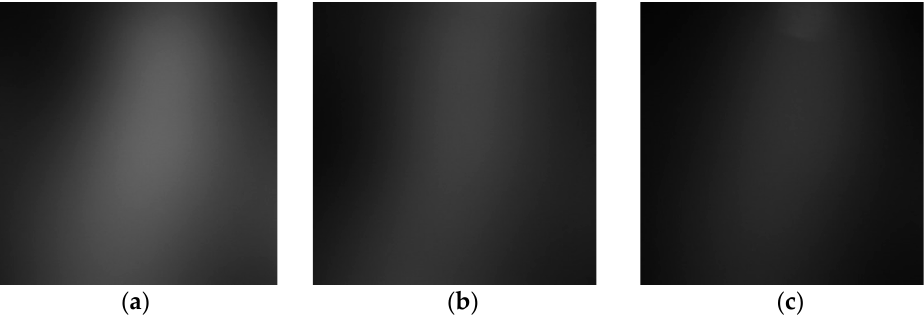
Figure 24. Tactile sensation images by depth: ( a ) 3 mm, ( b ) 5 mm, ( c ) 7 mm.